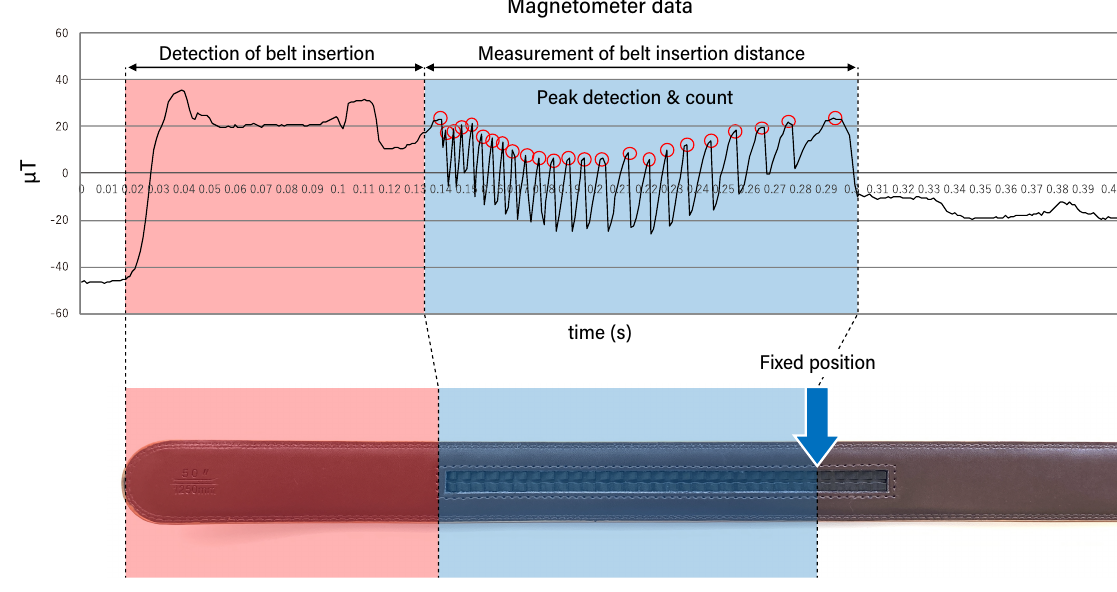
Figure 4. Mechanism of waistline